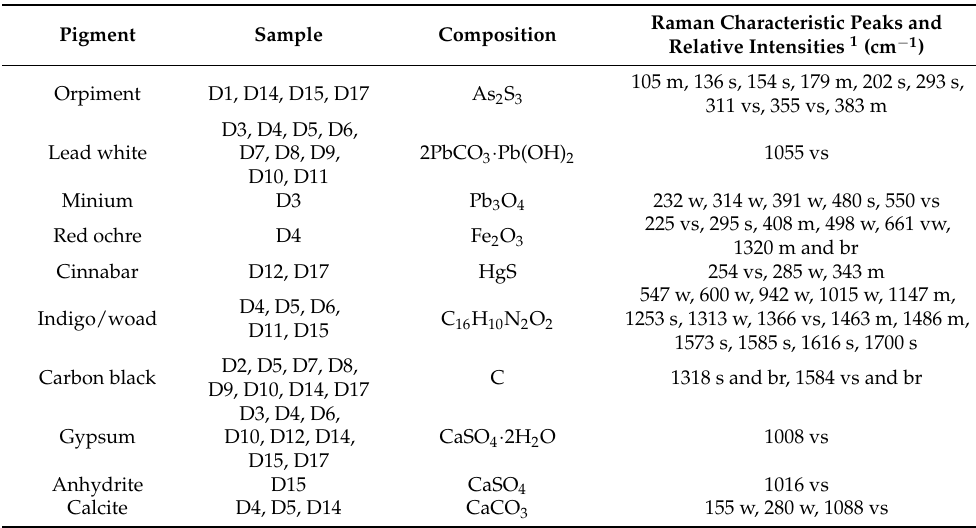
Table 2. Colourants identified in the investigated samples using micro-Raman spectroscopy. Charac- teristic peaks used for the identifications are